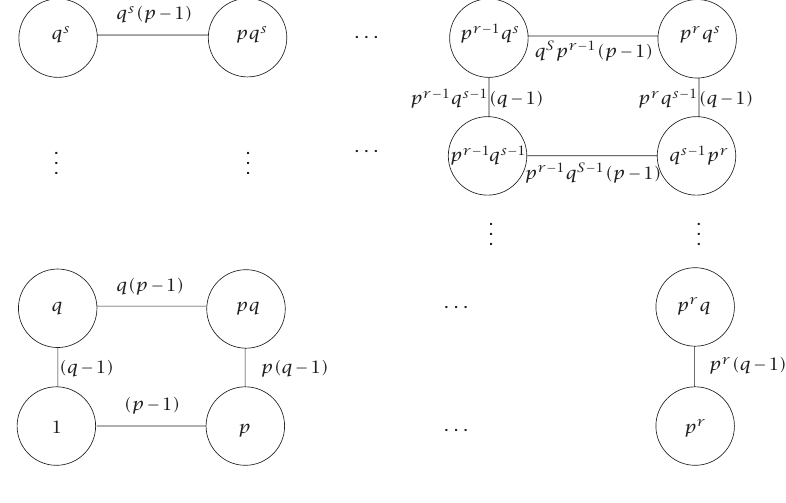
(cid:3) (cid:2) p r q s